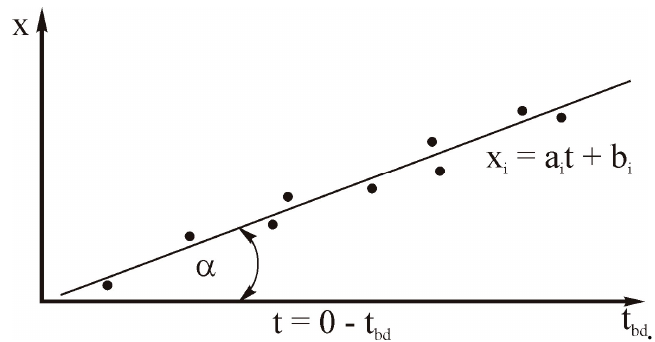
Figure 3. Graphic interpretation of the trend function.